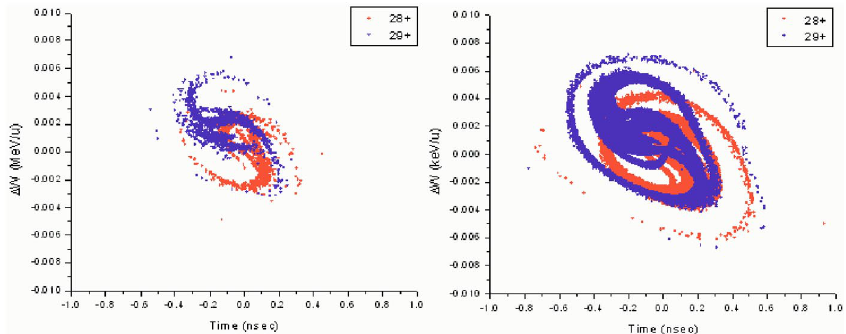
FIG. 6. (Color) Longitudinal phase-space plots at the entrance of the SC linac for two different numbers of simulated particles ( 4 (cid:6) 10 4 and 1 (cid:6) 10 6